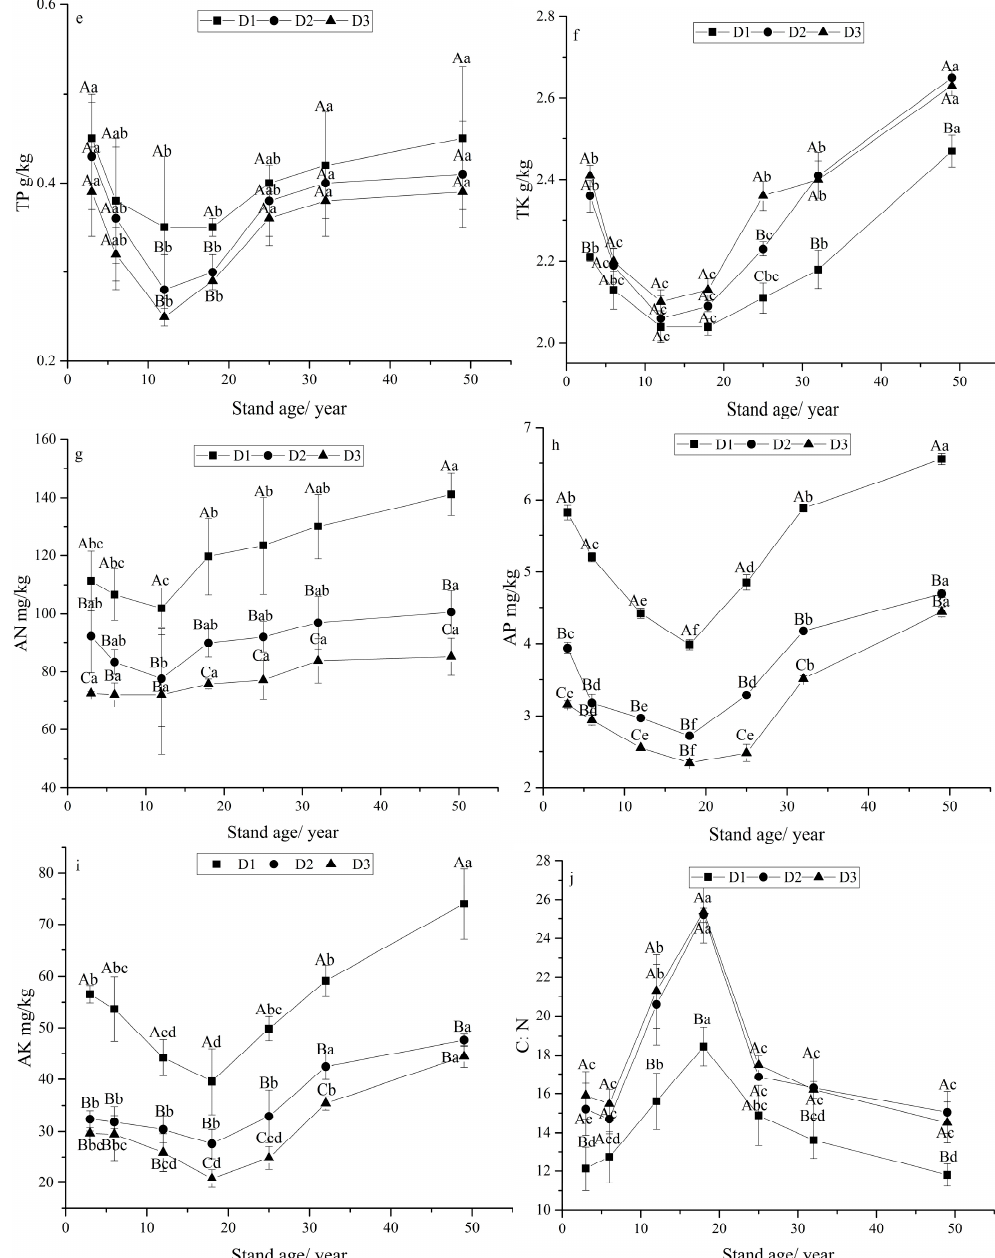
Figure 2. Soil physicochemical characteristics in the different age soils. ( a ) soil bulk density (SBD) values in different stand ages and different soil depths, ( b ) pH values in different stand ages and different soil depths, ( c ) soil organic matter (SOM) contents in different stand ages and different soil depths, ( d ) total nitrogen (TN) contents in different stand ages and different soil depths, ( e ) total phosphorus (TP) contents in different stand ages and different soil depths, ( f ) total potassium (TK) contents in different stand ages and different soil depths, ( g ) alkali hydrolysis nitrogen (AN) contents in different stand ages and different soil depths, ( h ) available phosphorus (AP) contents in different stand ages and different soil depths, ( i ) available potassium (AK) contents in different stand ages and different soil depths, ( j ) the ratio of carbon to nitrogen (C: N) values in different stand ages and different soil depths. Different lowercase letters and different uppercase letters represent significant differences between the same soil depth (D1: 0–10, D2: 10–20 or D3: 20–30 cm) of different stand ages and between different soil depths (D1: 0–10, D2: 10–20 and D3: 20–30 cm) of the same stand age at p < 0.05,